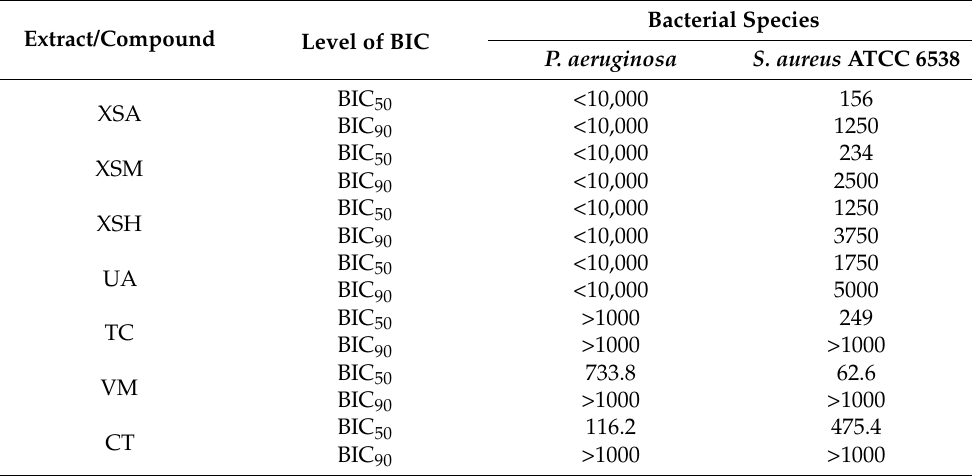
Table 8. The influence of acetonic, methanolic, and hexanic extracts as well as usnic acid of X. stenophylla on biofilm formation.